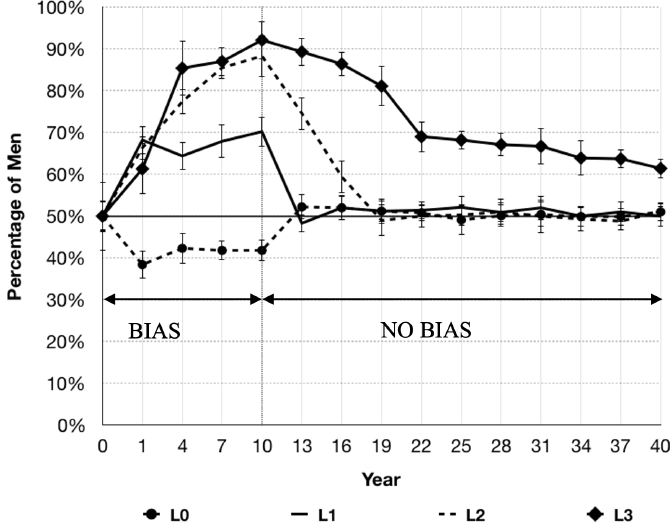
Figure 8. Gender balance across all four levels during a 40-year simulation that starts with a promo- tion bias of 0.5, which drops to 0.0 after 10